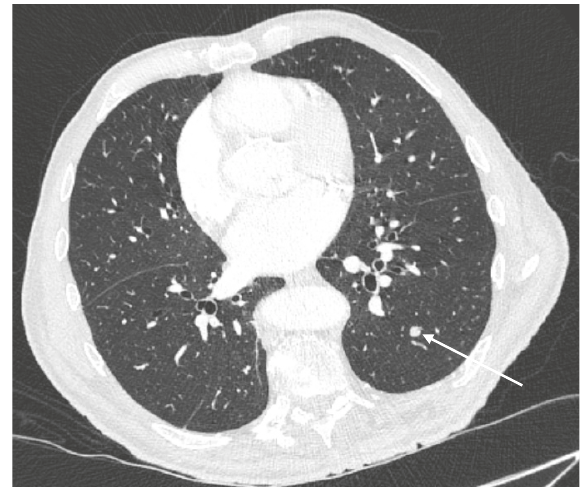
Figure 7: Axial CT image of the chest with lung windows revealing a pulmonary nodule in the posterior basal segment of the left lower lobe (white